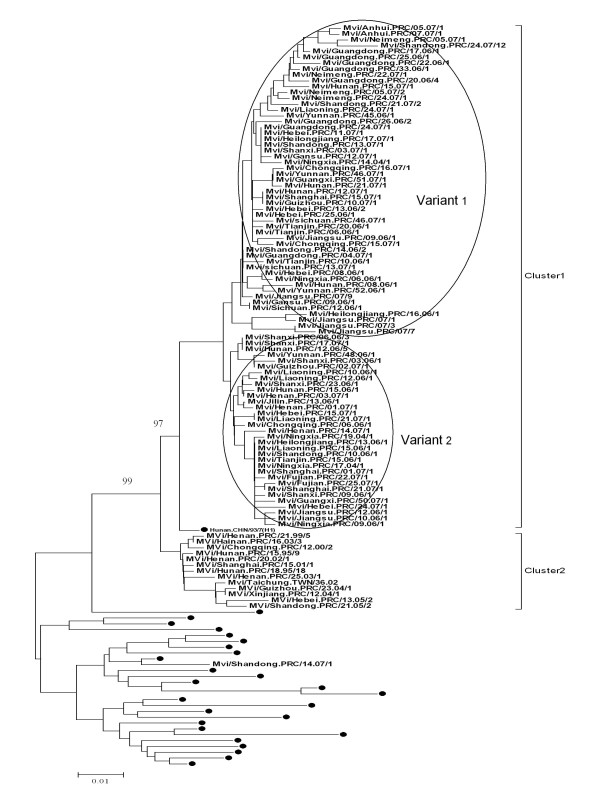
Phylogenetic tree of measles wild-type virus strains of China in 2006-2007 and WHO reference MeV strains (black dots) based on the 456 nucleotide sequences coding for the COOH-terminus of the nucleoprotein. The dendrogram was created with MEGA4 software and the neighbor-joining method (500 bootstraps). Genetic distances are represented as numbers of nucleotide differences between strains.